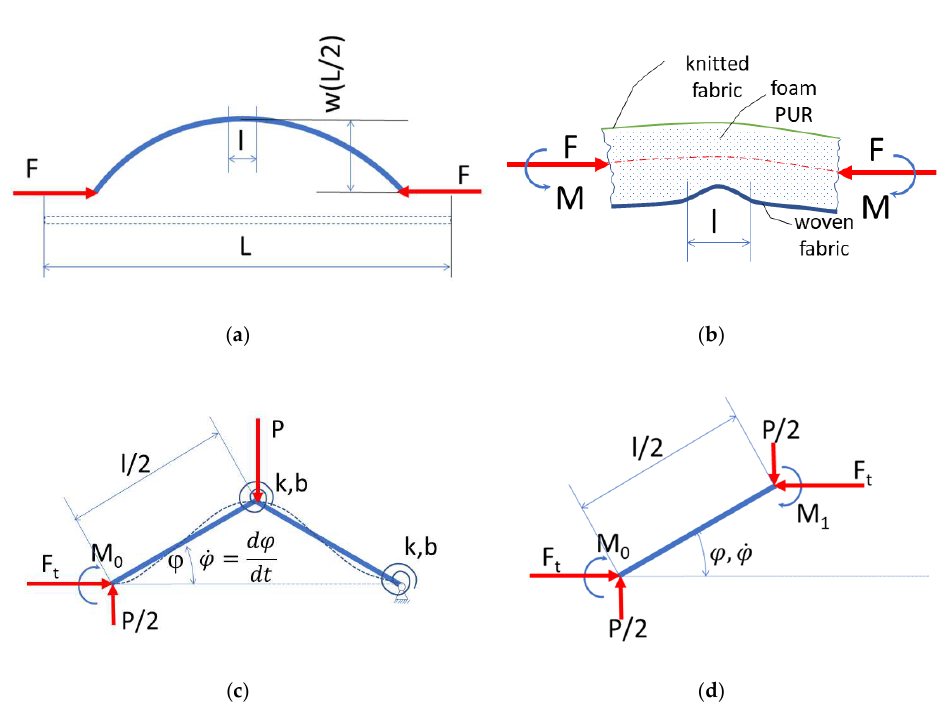
Figure 8. A model of textile laminate test sample of length L: ( a ) a sample of length L is subjected to horizontal forces F at both ends; ( b ) the fabric is pressed into the PUR foam mass, i.e., the textile laminate loses its shape stability; ( c ) a one-step fabric model; ( d ) the bending moment equilibrium equation of the free